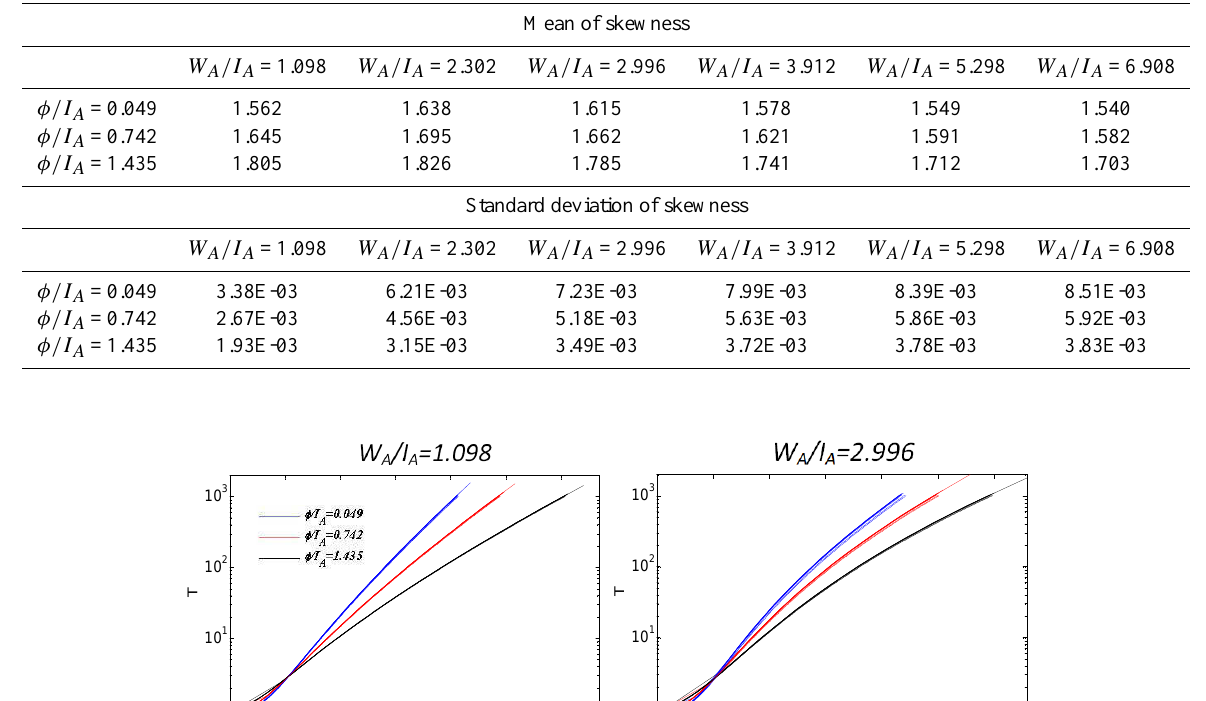
Table 7. Mean and standard deviation of skewness for r L =0.3, r H =0.6; A ranges from 10 to 500km 2 and I 1 ranges from 10 to 50mmh − 1 .